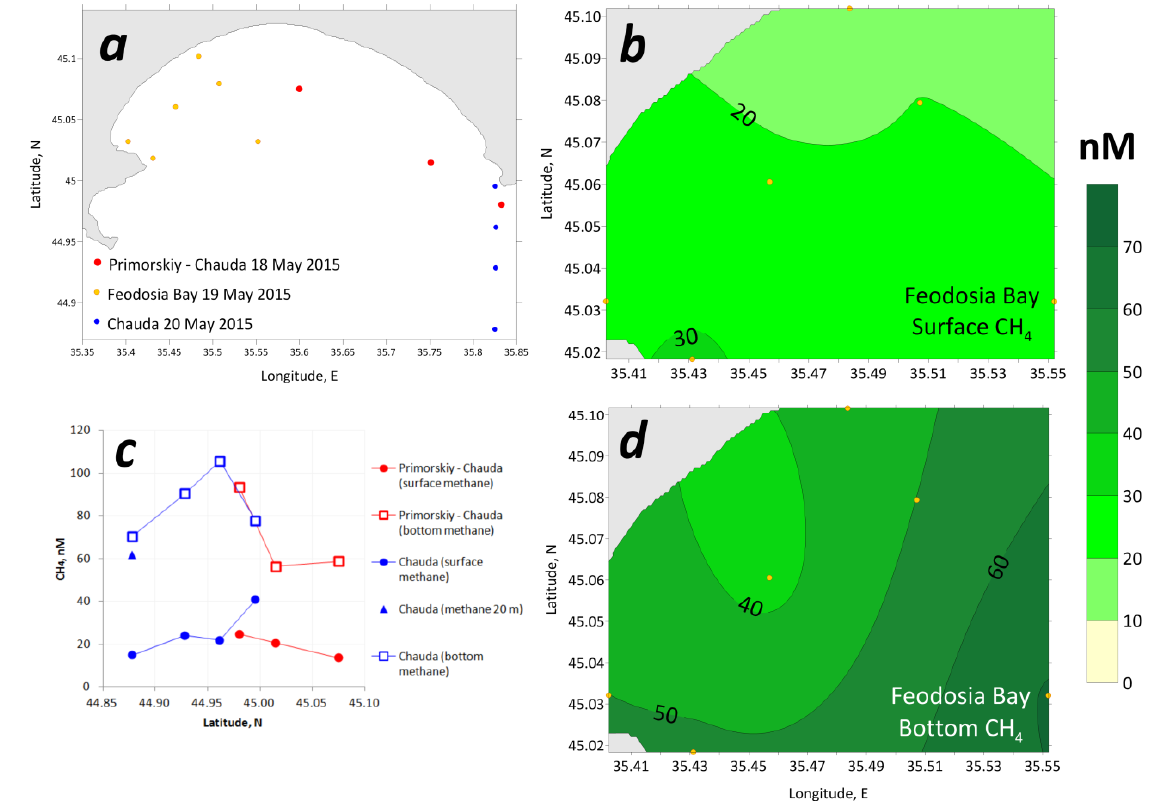
Figure 10. Location of water sampling stations in Feodosia Bay area, May 2015 ( a ). Methane content in the surface waters in the western part of the bay ( b ), on the sections ( c ), in the bottom waters in the western part of the bay ( d ).